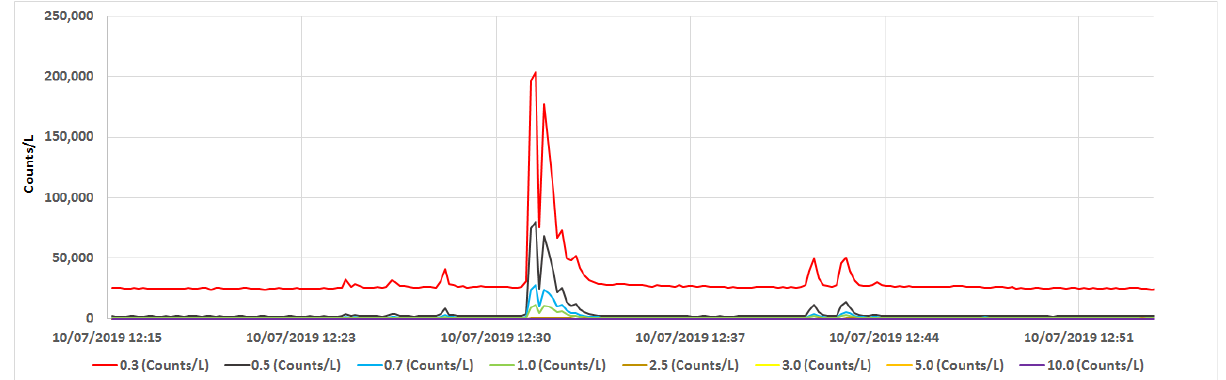
Figure 6. Real-time graph of ECSHA measured in counts/L using “JUUL” ECs, with a sampling time